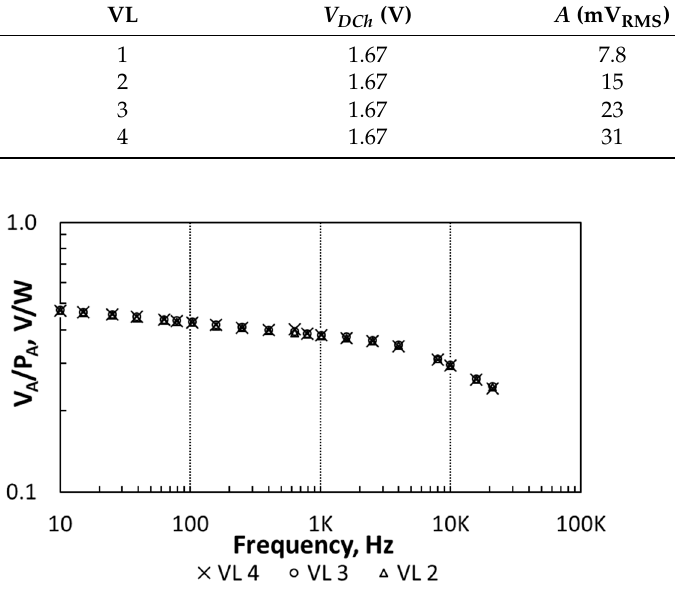
Figure 5. Measurements of transducer sensitivity as a function of the frequency. Three different voltage levels (VL) for the heating device are considered.